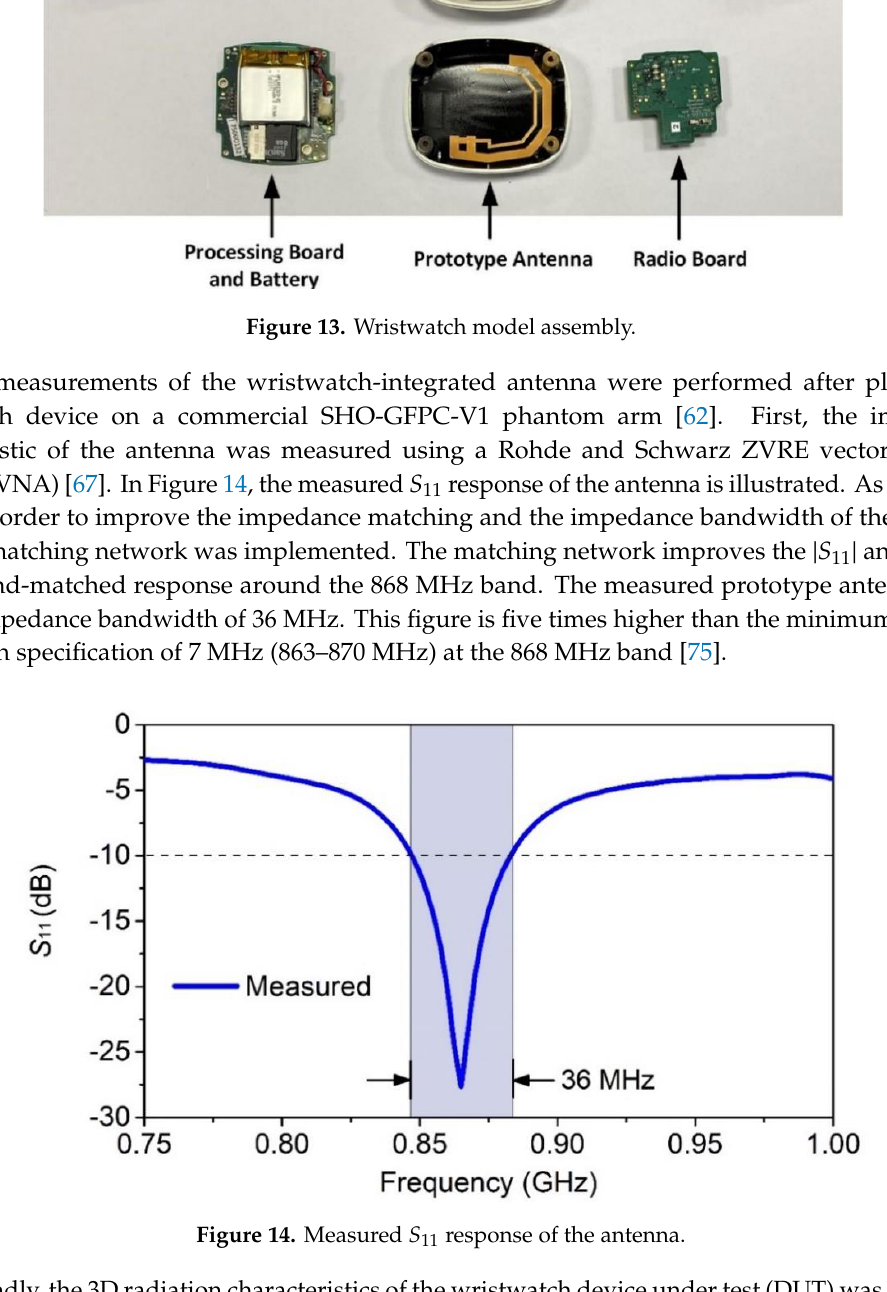
Figure 12. LPKF laser direct structuring (LDS) printed antenna.